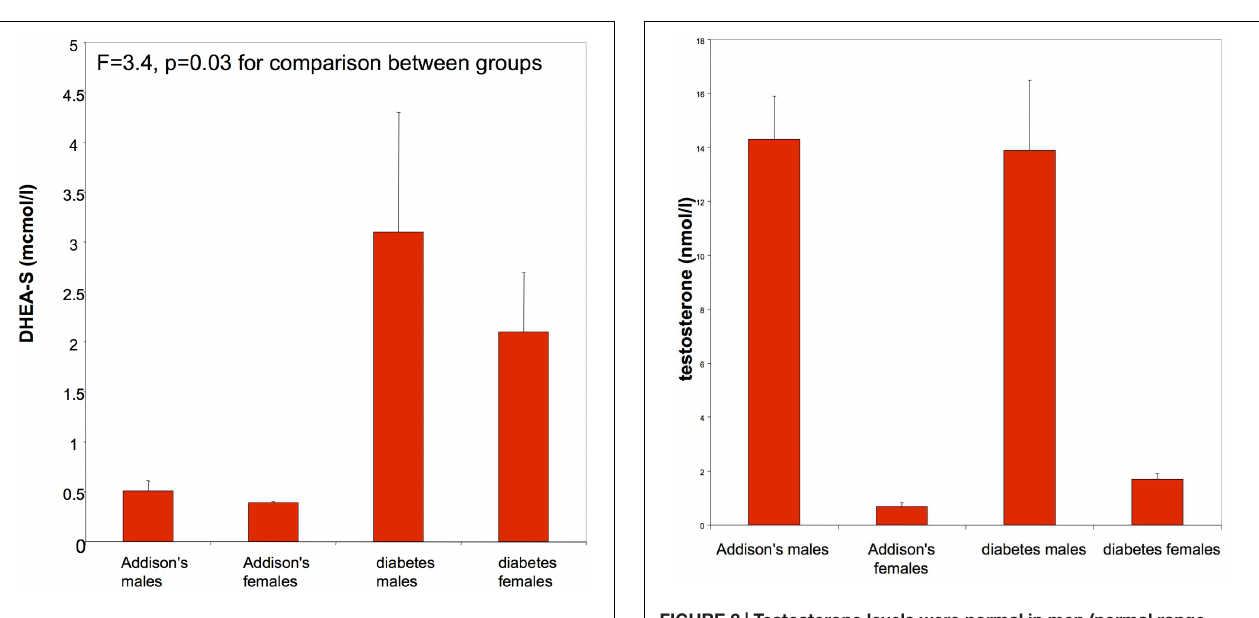
FIGURE 1 | DHEA-S ( µ mol/l) was low in male Addison’s patients (mean ± SE: 0.5 ± 0.1; normal range mean: 2.2–15.2) and female patients (mean ± SE: 0.4 ± 0.01; normal range mean: 1.0–12.0). DHEA-S levels were normal in type 2 diabetes patients.